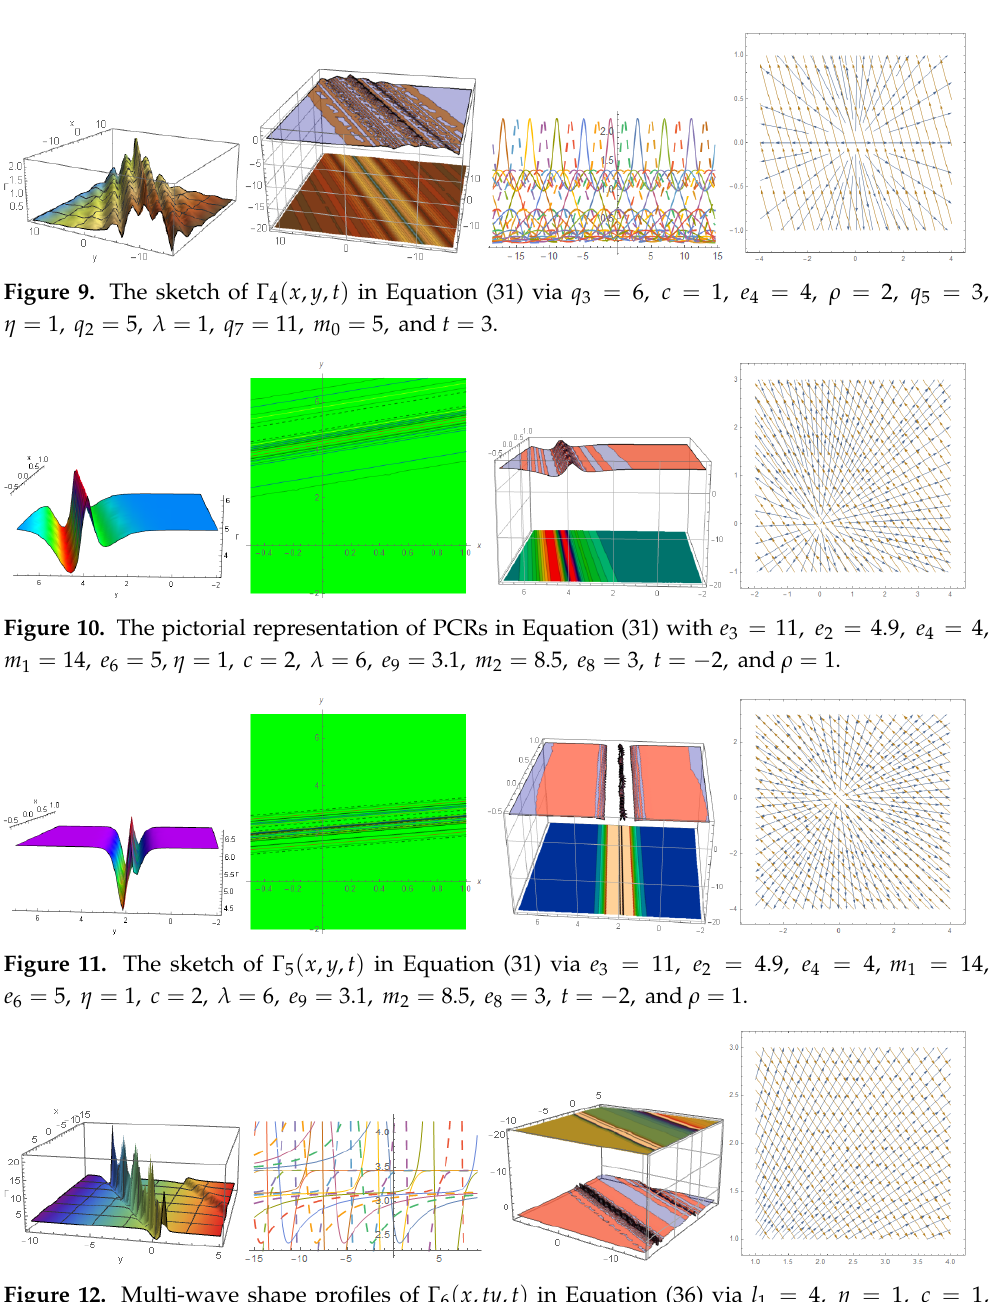
Figure 12. Multi-wave shape profiles of Γ 6 ( x , ty , t ) in Equation (36) via l 1 = 4, η = 1, c = 1, ρ = 3, l 0 = 2, m 2 = 3, m 6 = 2, λ = 1.2, δ = 2, l 2 = 12, t = 9, and m 4 = 3.